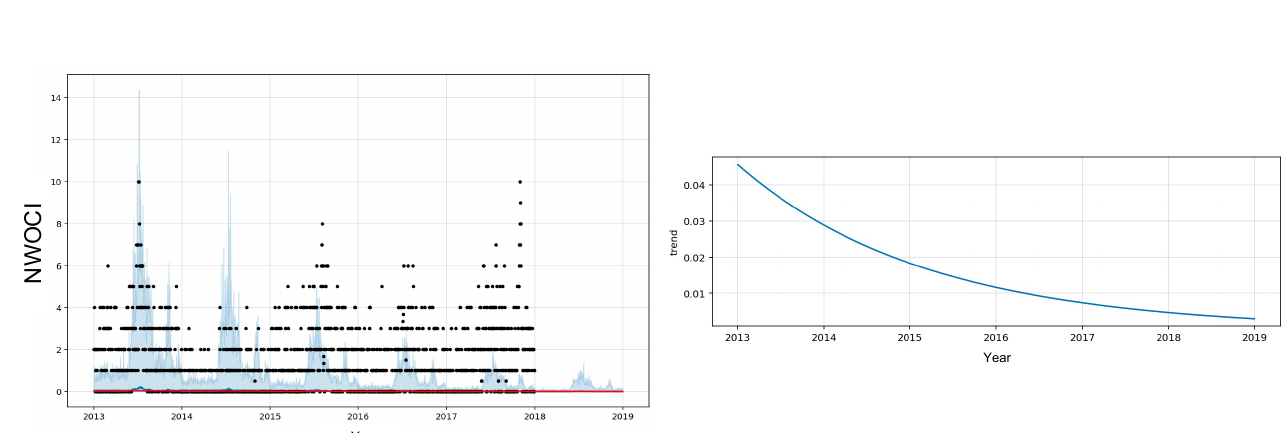
Figure A3. Left : One year forecast (2018 test data) from Prophet-BU Model for Bristol county in MA. N.B: The solid blue line shows the average forecast while the solid red line shows the observed trend of NWOCI and the light blue region represents the 80% confidence interval for the forecast uncertainty. Also, the scatter points represent the historical values in the training data (2013–2017). Right : Trend decomposition from Prophet-BU Model for Bristol county in